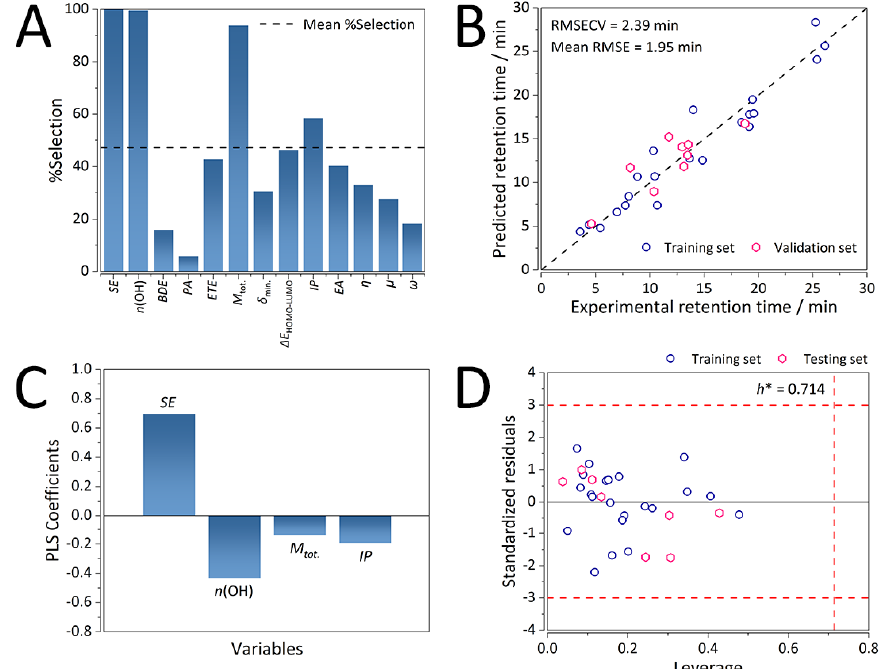
Figure 2. Performance characteristics of the consensus genetic algorithm-partial least squares (GA-PLS) quantitative structure retention relationships (QSRR) model for the C18 column. ( A ) Occurrence (expressed through % of selection) of molecular descriptor selection in 1000 GA-PLS runs. ( B ) Predictive ability on the training and validation sets ( n = 30). ( C ) Distribution of the PLS coefficients (intercept = 0, due to autoscaling). ( D ) Applicability domain computed on the training and testing sets. Warning limits: three multiples of the standard deviation of standardized residuals, and critical leverage ( h *) of 0.714 ( n = 30). Royal blue circles depict the training set observations, whereas the pink diamonds depict the testing set observations. Table 2. Statistical significance of the consensus genetic algorithm-partial least squares (GA-PLS) model for the K-C18 column.